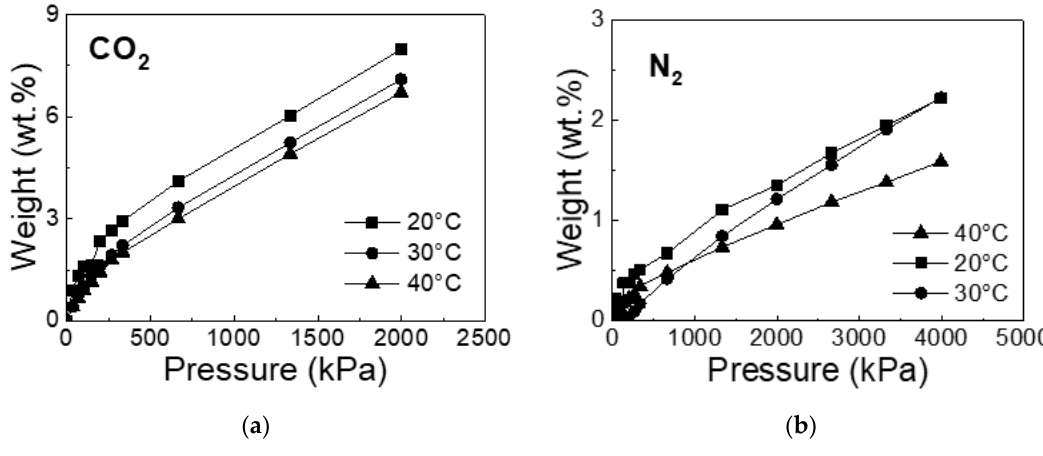
Figure 4. Adsorption isotherms of CO 2 ( a ) and N 2 ( b ) for CBp at 20, 30, and 40 °C.